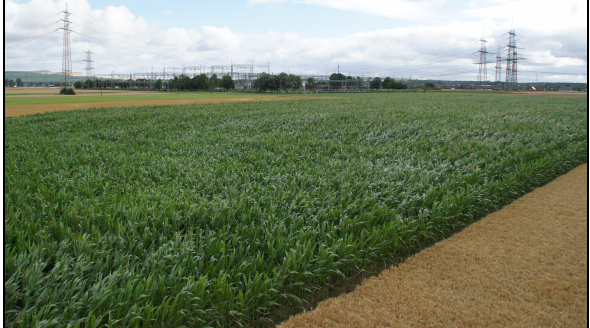
Figure 4. Northeast looking photo of the maize field on July 31 st , just before the 4 th WorldView-2